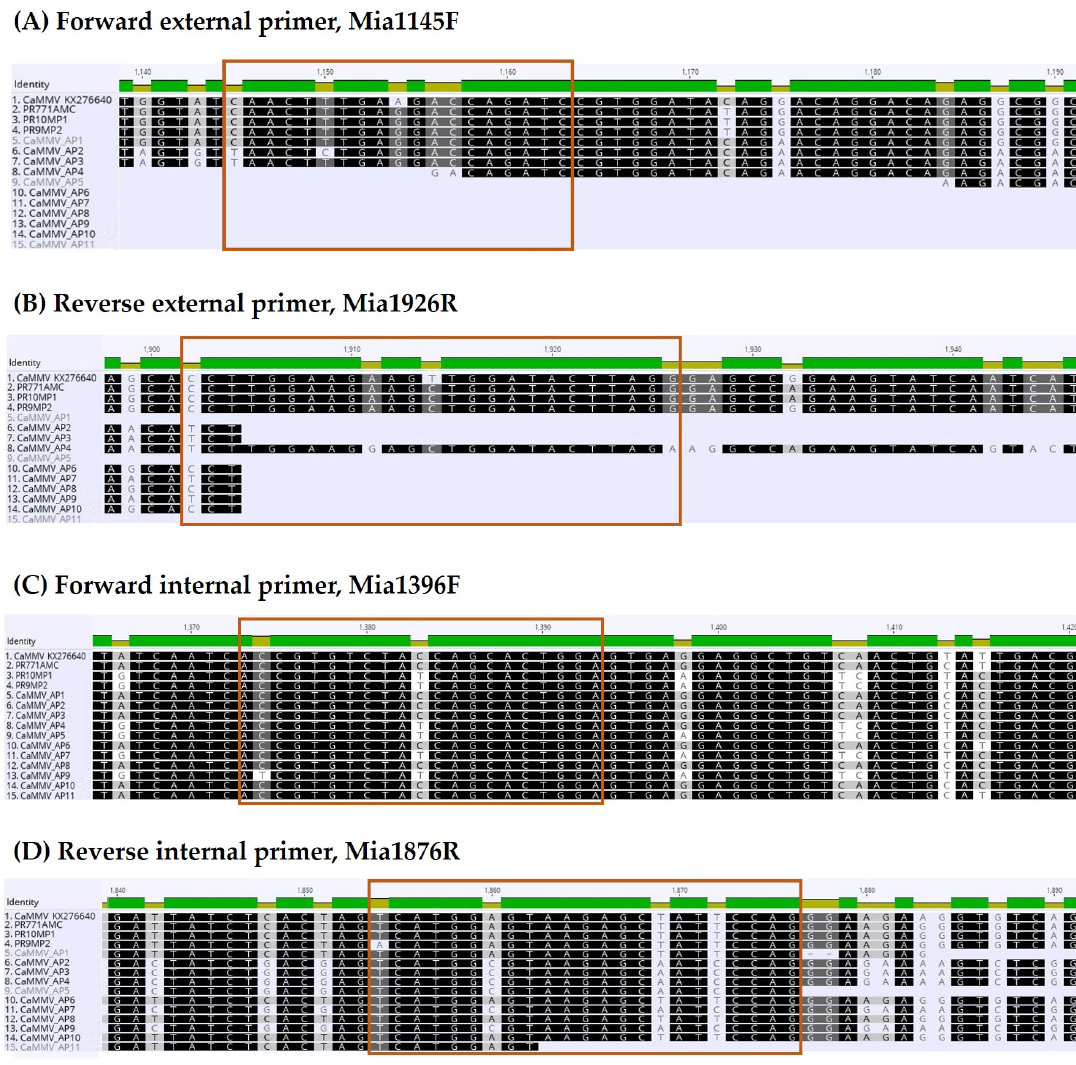
Figure 3. Alignment of partial sequences of the movement protein–coat protein region of Cacao mild mosaic virus (CaMMV) strains. The red frame indicates the annealing sites of the ( A ) Forward external primer, Mia1145F, ( B ) Reverse external primer, Mia1926R, ( C ) Forward internal primer, Mia1396F, and ( D ) Reverse internal primer, Mia1876R. Light areas indicate nucleotide differences among